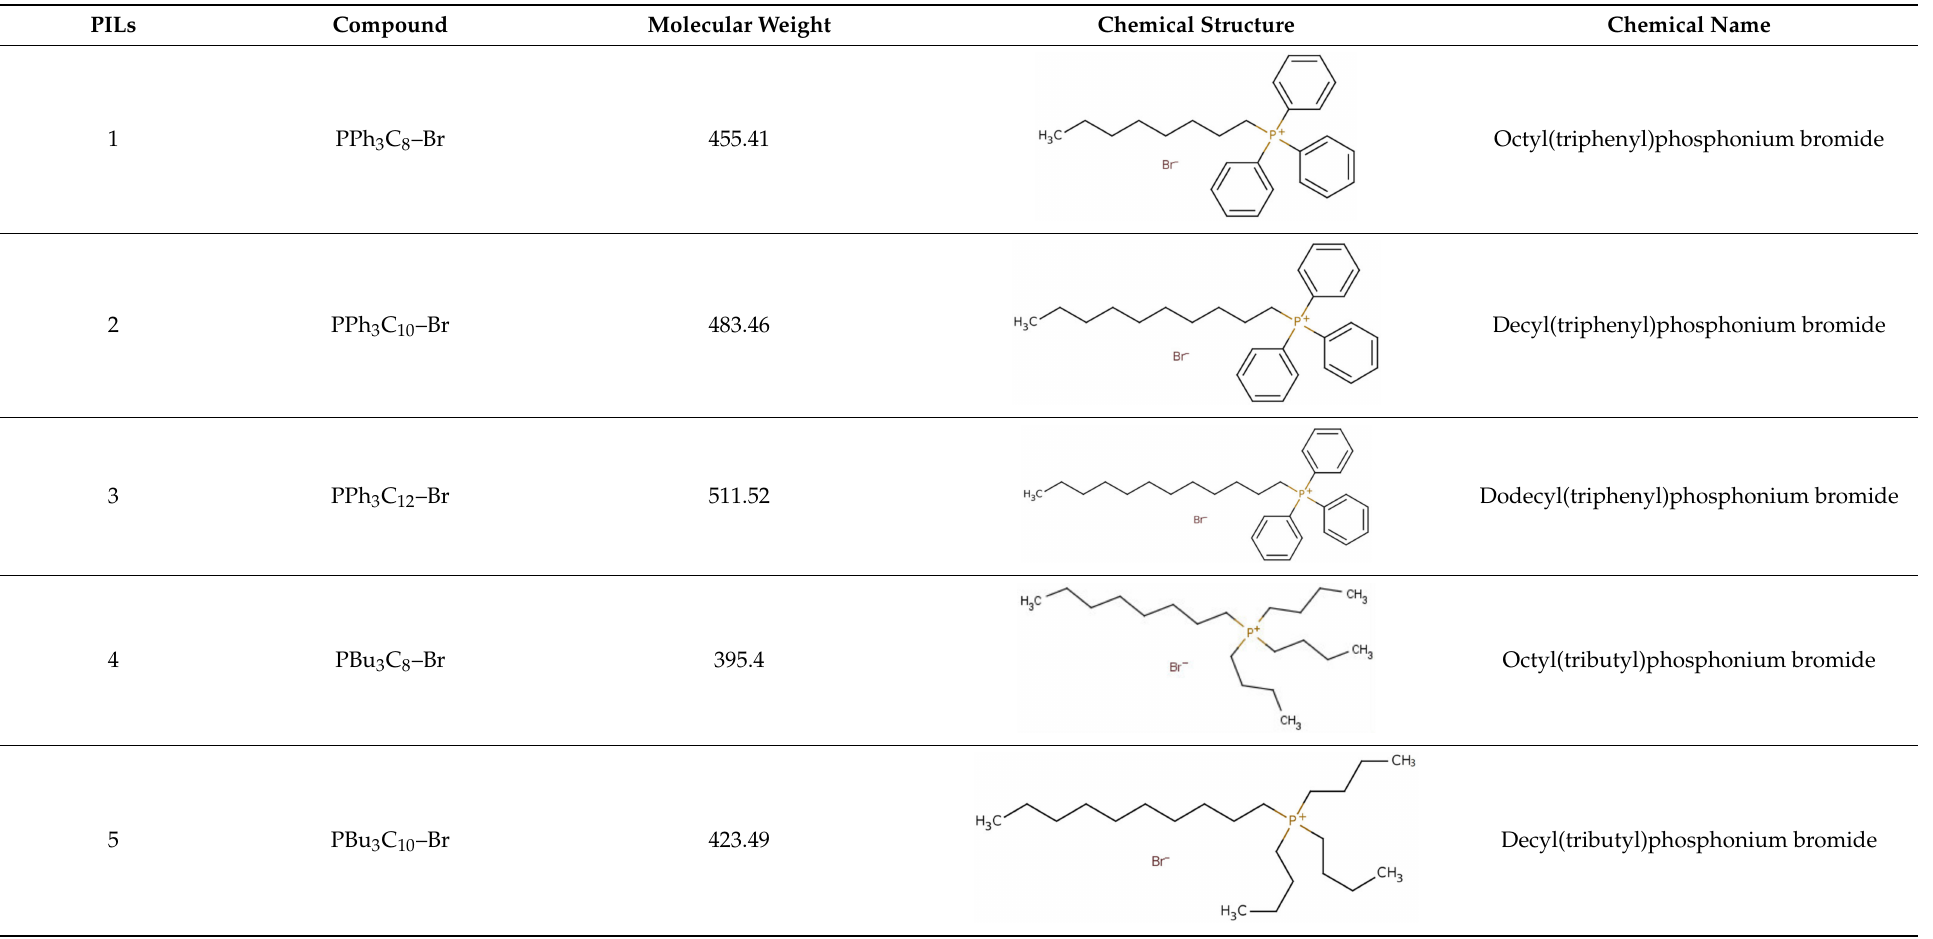
Table 2. Chemical structures of the synthesized compounds tested for their antibacterial